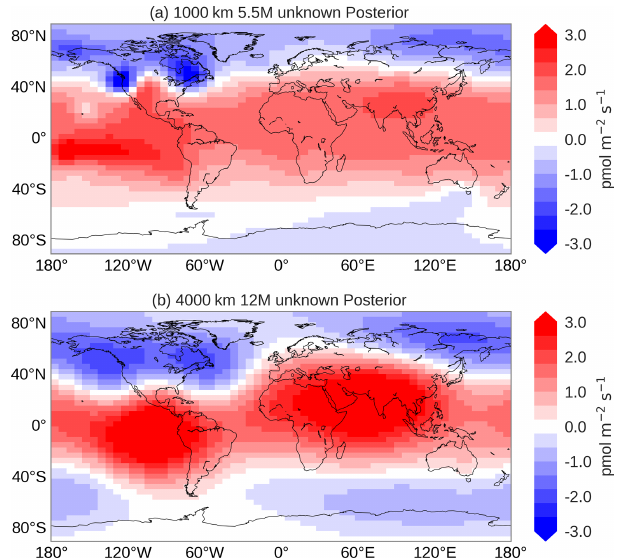
Figure 5. Optimized emission pattern of the unknown field of in- version S u for different settings of the spatio-temporal correlation lengths. (a) Spatial correlation of 1000km and temporal correlation of 5.5 months. (b) Spatial correlation of 4000km and temporal cor- relation of 12 months. Results are averages over